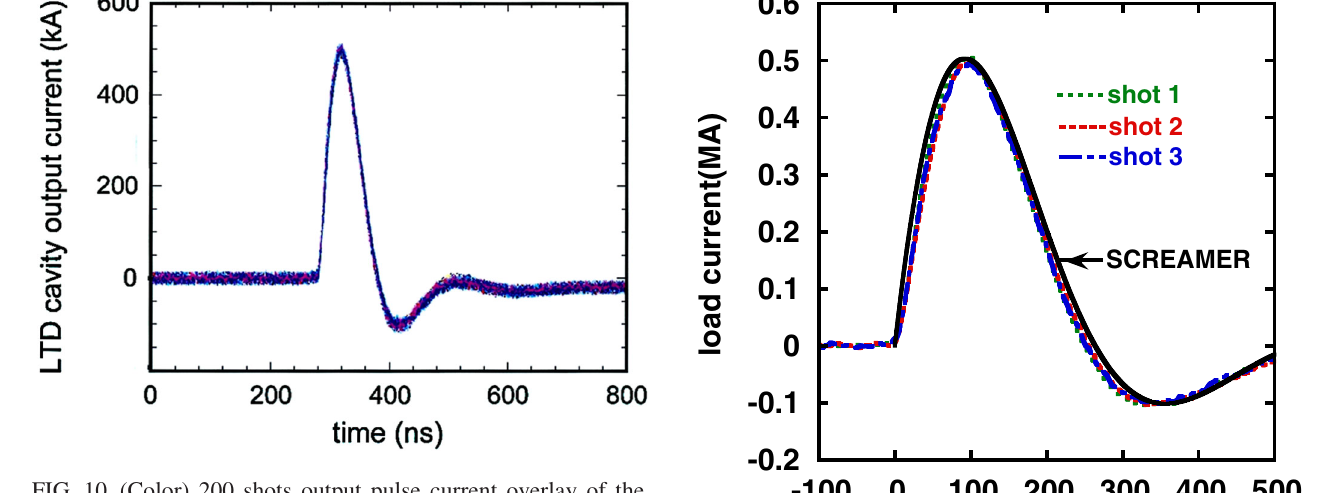
calculations.FIG. 10. (Color) 200 shots output pulse current overlay of the prototype LTD I